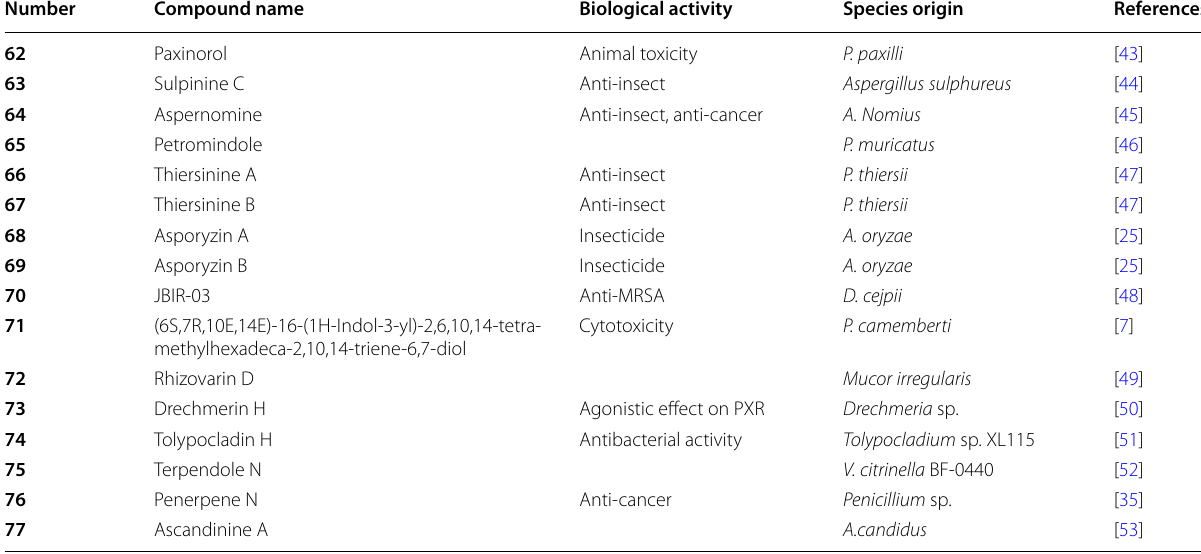
Table 6 Name, bioactivities and source of other types of